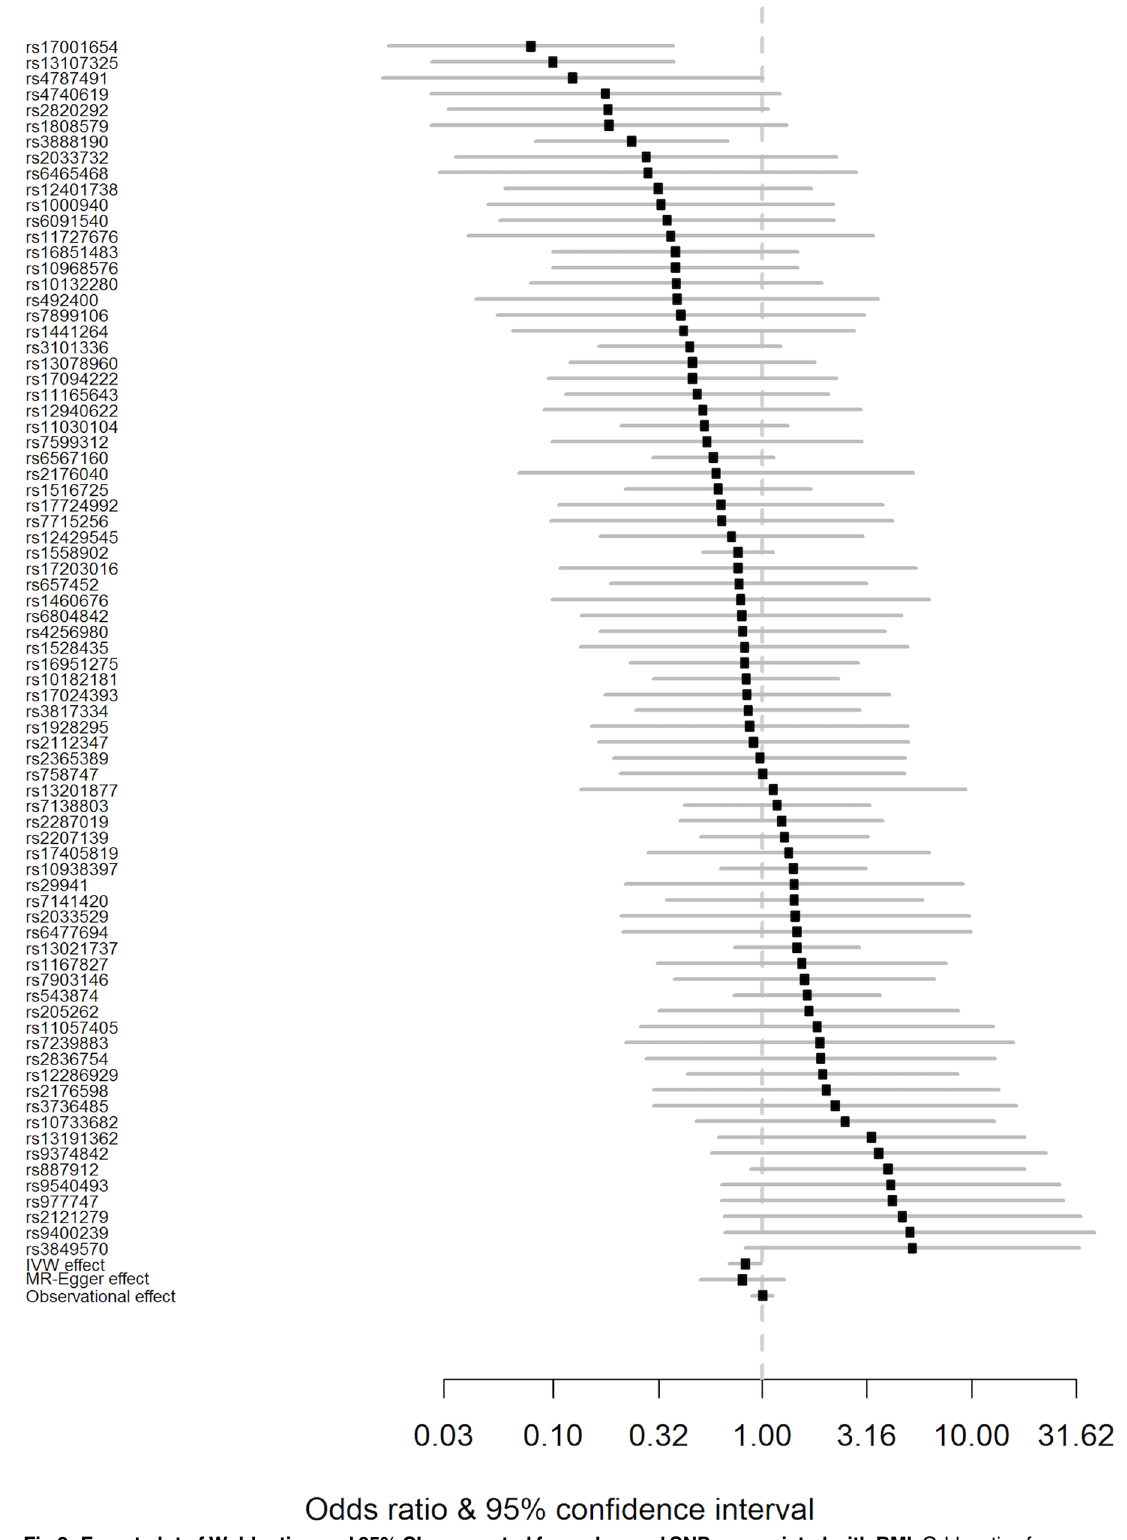
Fig 2. Forest plot of Wald ratios and 95% CIs generated from clumped SNPs associated with BMI. Odds ratios for individual SNPs are listed accordingto magnitudeof effect in the instrumental variableanalysisand are presented with pooled